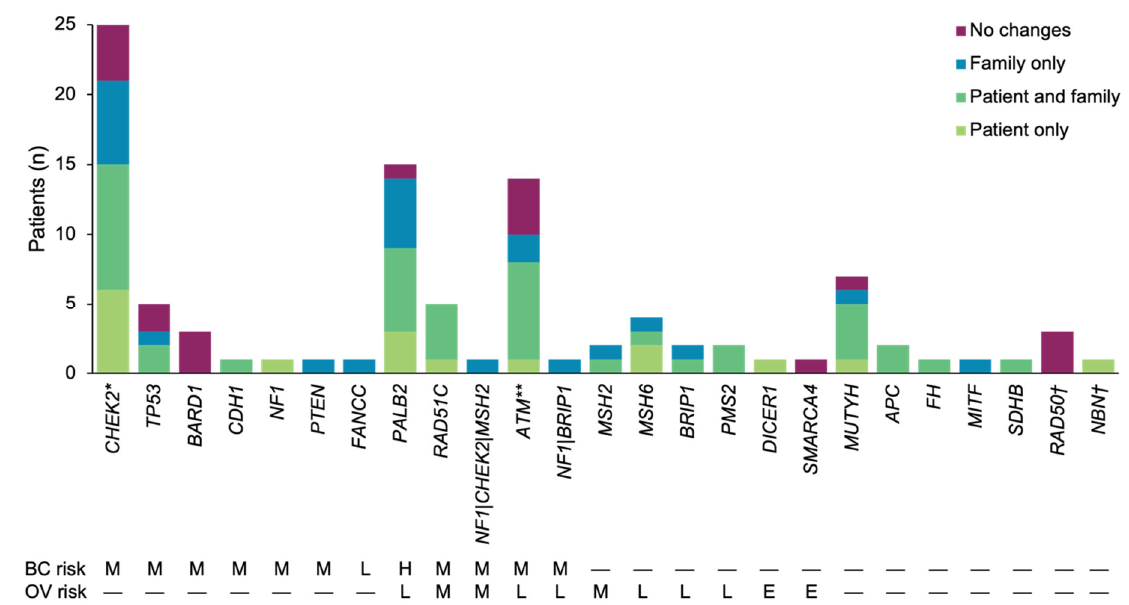
Figure 1. Distribution of P/LP variants in genes with known cancer risks and clinical recommendations, stratified by cancer risk. For each gene with P/LP variants, it was determined whether any results-based recommendations were made for the patient and/or their family members. Total number of patients with a P/LP variant in each gene is indicated. * One individual with a P/LP variant in CHEK2 also had a P/LP variant in MUTYH . ** One individual with a P/LP variant in ATM also had a P/LP variant in NBN . † RAD50 and NBN do not have associated breast or ovarian cancer risks, but do have implications for clinical trial eligibility. BC, breast cancer; E, elevated but undefined risk due to limited data; H, high; L, minimally increased; M, moderate; OV, ovarian cancer; P/LP, pathogenic/likely pathogenic.